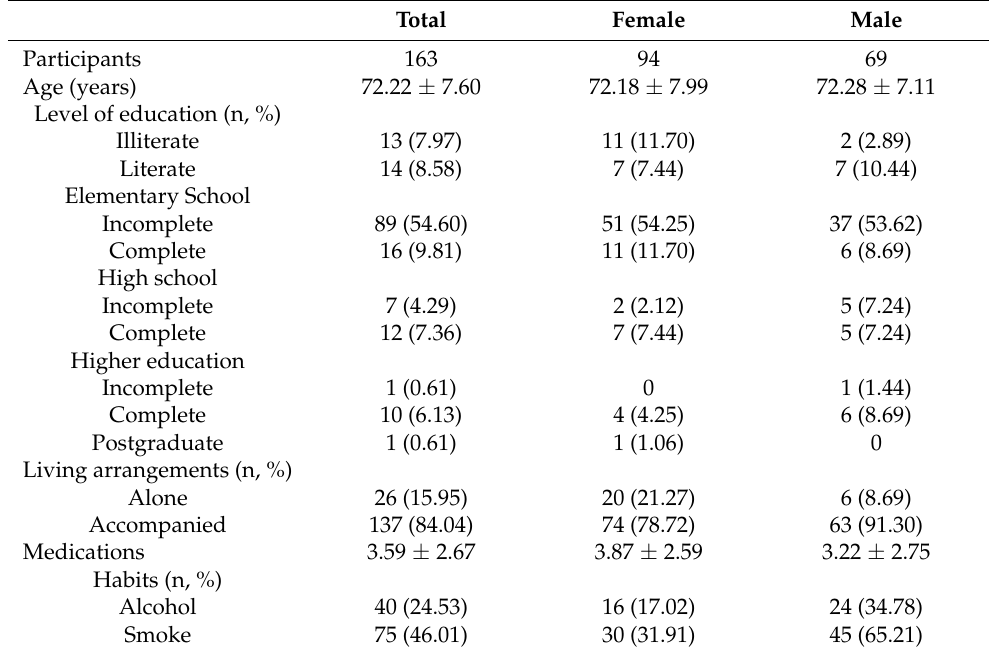
Figure 2. ( A ): Mean ± standard deviation for each risk group of the sensory domain. * p < 0.001 compared to high risk. ( B ): Absolute frequency of older adults in each risk group. In Figure 3, although a small number of elderly people were categorized as high and moderate risk of having psychological disorders (B), there was also a significant difference in relation to the scores between the risk categories (A). Few people categorized as high/moderate risk does not mean they do not require short-term attention. Figure 3. ( A ): Mean ± standard deviation for each risk group of the psychological domain. * p < 0.001 compared to high risk. ( B ): Absolute frequency of older adults in each risk group.